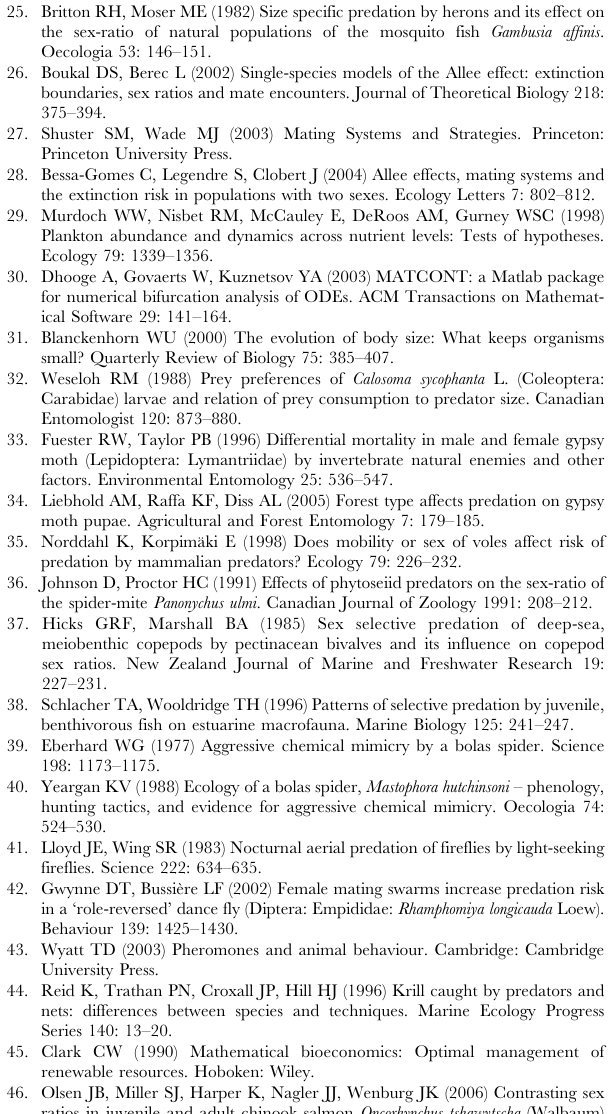
except the dotted curve that delimits the area of stable E 2 for unlimited polygyny (infinite h ). Figure S2 Stability of model (S1) in Text S2 with unlimited polygyny and no mate-finding Allee effect. Combined effect of predation bias and parameter K scaling the prey carrying capacity. Other parameters: b =3, d = 0.2, H = 0, e 1 = 0.2, e 2 = 0.1, and M = 1. E 2 is locally stable within the grey area. Areas I and II delimited by line L = 1 refer to Table 2 in the main text. Figure S3 Stability of model (S2) in Text S2 with unlimited polygyny and no mate-finding Allee effect. Combined effect of predation bias and steepness in predator switching on the stability of the predator-prey equilibrium E 2 of model (S2). Parameters: b =3, d = 0.2, Q= 0, e 1 =0.2, e 2 = 0.1, and M =1. E 2 is locally stable within the grey area. Areas I and II delimited by line L = 1 refer to Table 2 in the main text. Found at: doi:10.1371/journal.pone.0002687.s006 (0.96 MB TIF)